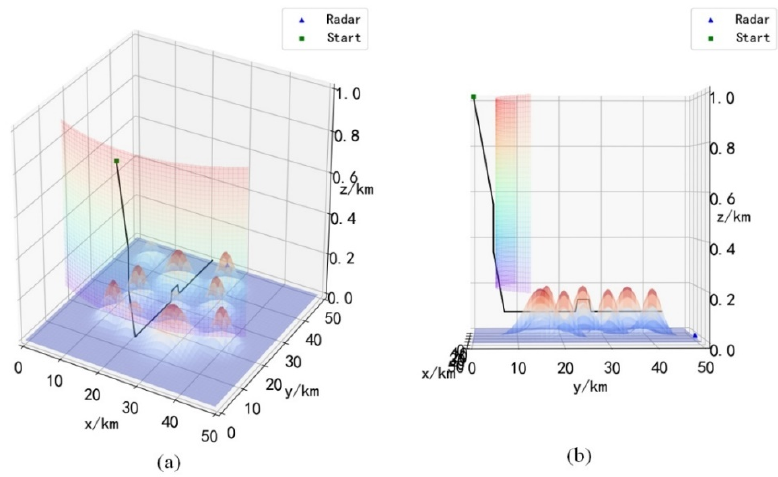
Figure 17. The path planning result by Dijkstra and A* algorithms in scenario 4. ( a ) is the full view of the path, ( b ) is the side view of the path.